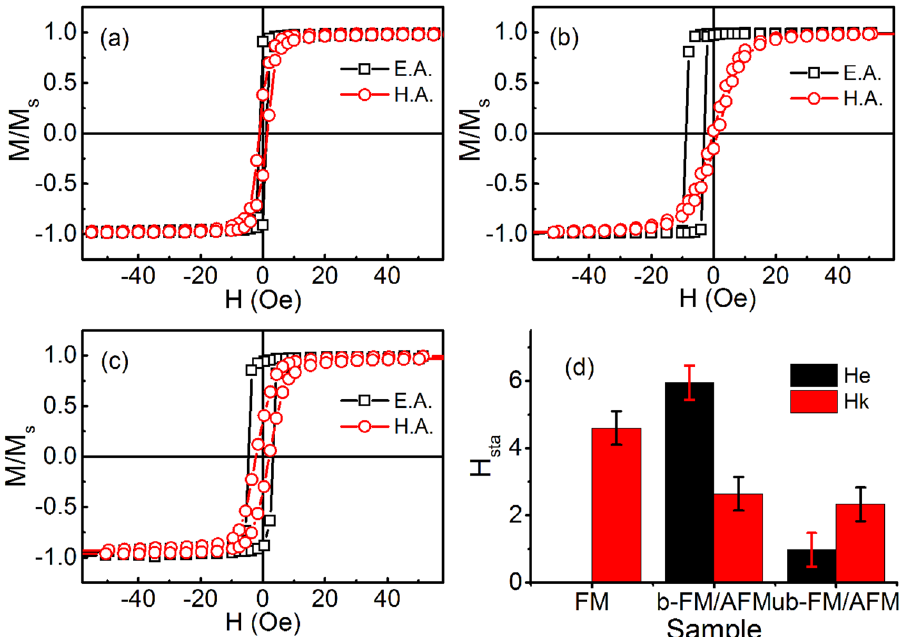
Figure 1. In-plane magnetic hysteresis loops and static anisotropies of the films. ( a ) Fe 20 Ni 80 single layer with thickness of 50 nm, ( b ) biased Fe 20 Ni 80 /Fe 50 Mn 50 bilayer (i.e. a permanent magnetic field was applied adjacent to the substrate during the depositing), ( c ) unbiased Fe 20 Ni 80 /Fe 50 Mn 50 bilayer, measured along easy axis (E.A.) and hard (H.A.) axis, respectively. ( d ) the statistical result of static magnetic properties of the films, black shadow and red shadow are the exchange bias field H esta and uniaxial anisotropy field H ksta extracted from the hysteresis loops